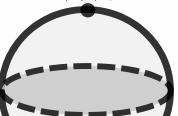
1 . In contrast to the 2